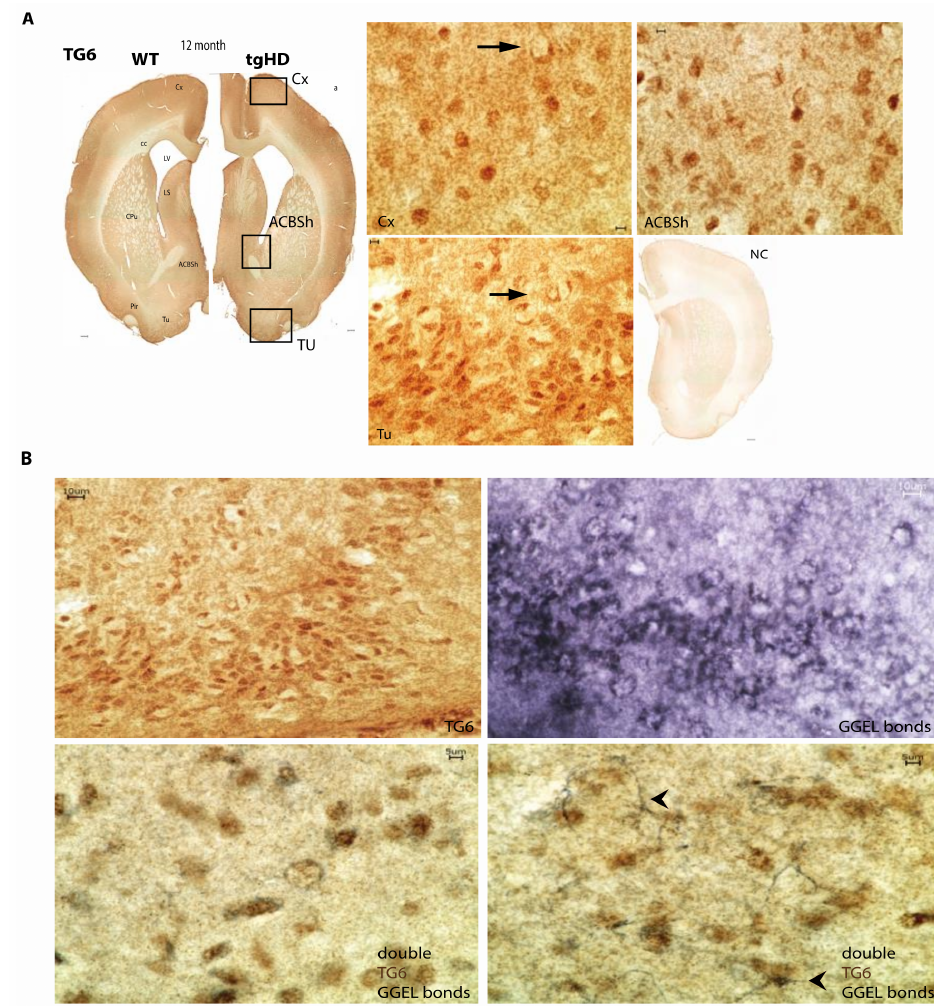
Figure 2. Regional distribution of TG6 and TG-enzymatic reaction products in the brain of tgHD rats. ( A ) The distribution of TG6 is prominent and widespread in the brain of 12-month-old rats, displaying no genotype-dependent differences. The expression level of the TG6 protein was highest in the cortex (Cx; inlay right panel), especially in the piriform cortex (Pir), the lateral septum (LS), the olfactory tubercle (Tu, inlay right panel) and the shell of the nucleus accumbens (ACBSh, inlay right panel). The location of three inlays on the right is indicated within the adjacent tissue overview section (left thumbnail). ( B ) TG6- and 81D4-positive (N-epsilon-gamma glutamyl lysine/GGEL) signals could also be found in neurons. Furthermore, isopeptide bonds could also be found in astrocytes, which appeared in close proximity to TG6 positive neurons (arrowhead). Scale bars: 5, 10, 300 µ